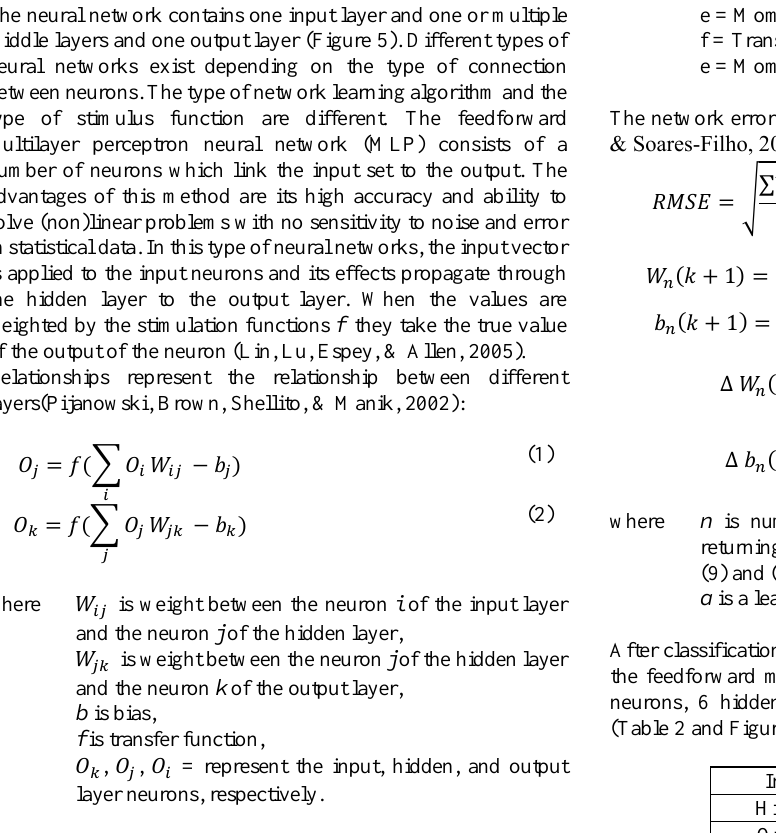
Figure 4. The classified land use maps for (a) 2002, (b) 2008, (c) 2014 Landsat images